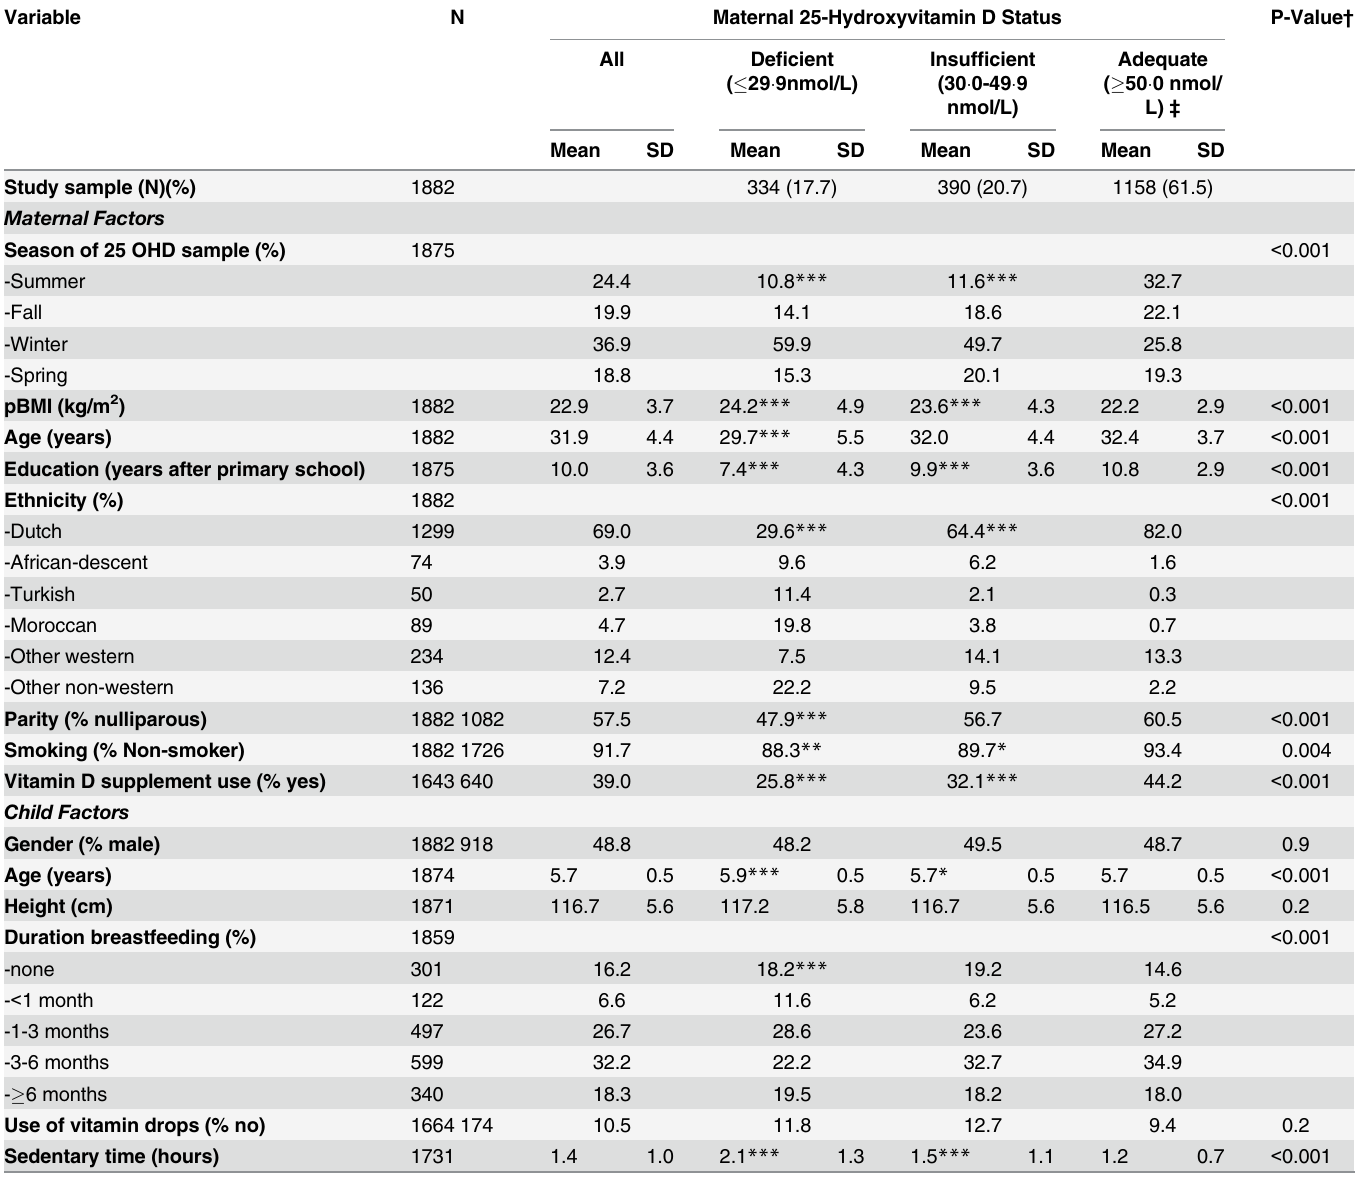
Table 2. Study population characteristics as a function of maternal 25-hydroxyvitamin D status in early pregnancy.